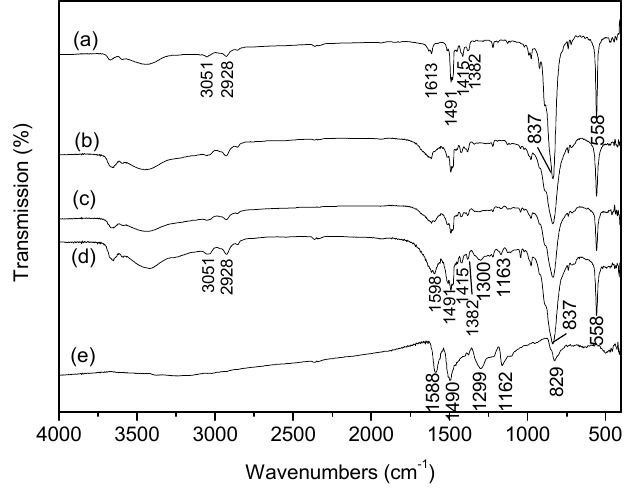
Figure 2. Fourier transform-infrared spectrum (FT-IR) spectra of samples: ( a ) P[VBTMA][PF 6 ]; ( b ) P[VBTMA][PF 6 ]-c-PANI (10 wt %); ( c ) P[VBTMA][PF 6 ]-c-PANI (20 wt %); ( d ) P[VBTMA][PF 6 ]-c-PANI (40 wt %); ( e ) PANI.